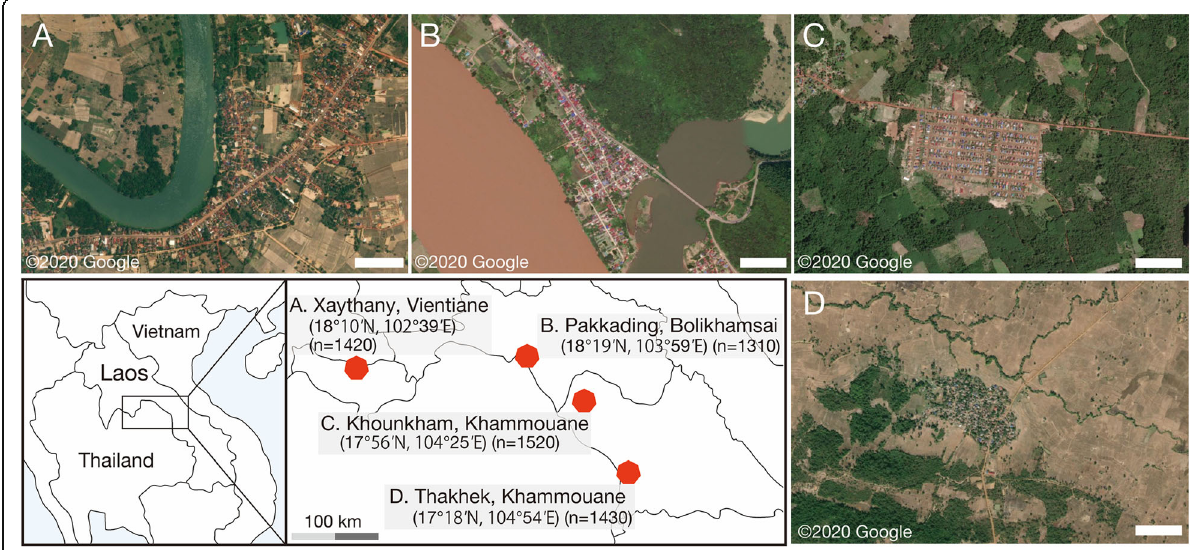
Fig. 1 Sampling sites and status of mosquito larvae at each site in central Lao PDR. a , b Suburban townships along the national highway